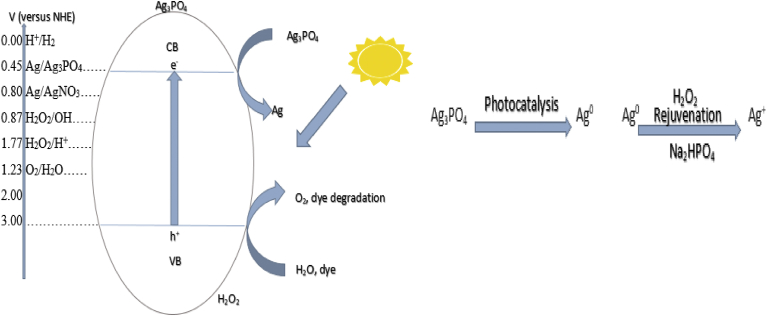
Redox potentials of Ag3PO4 (left) and reversible photocatalytic activity of Ag3PO4 (right).